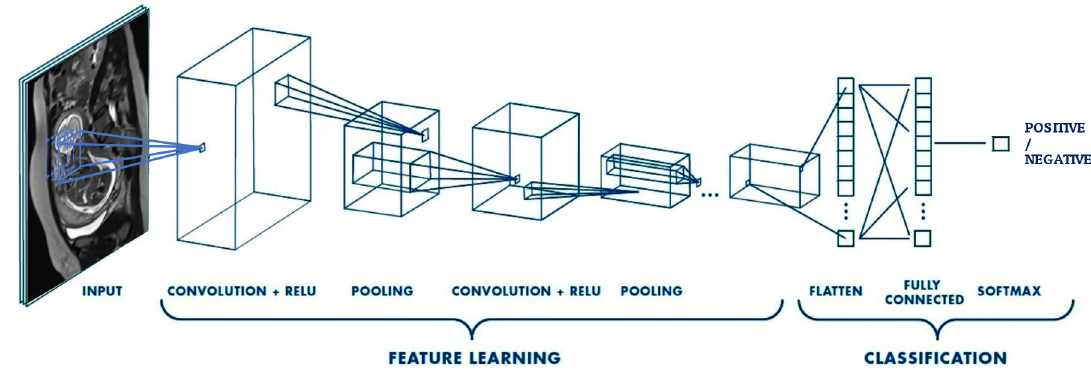
Fig 9. Schematic of the architecture of a convolutional neural network (CNN). A CNN is composed of several kinds of layers, namely the convolution layers and the pooling layers. One of the most significant differences between deep networks and other ML algorithms is the use of ReLU as a transfer function to make the algorithm faster. Then, the outputs generated by the previous levels are "flattened" to transform them into a single vector that can be used as an input for the next level. The fully connected layer applies weights to the input generated by the feature analysis to predict an accurate label. Finally, the fully connected output layer and softmax produce the final outputs in order to determine the class to associate with the image.